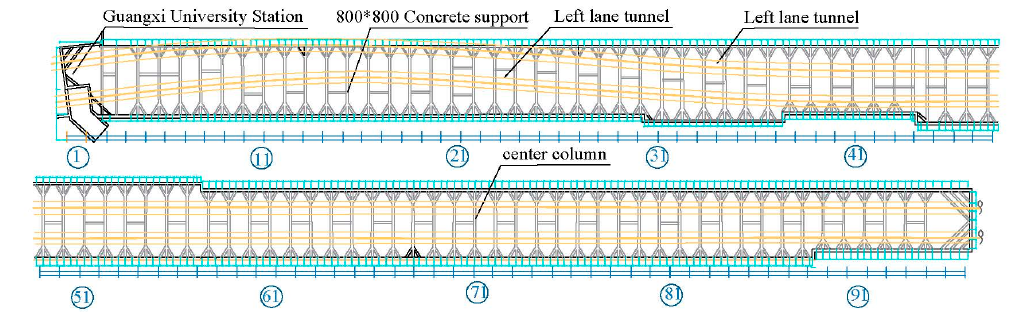
Figure 6. Supporting structure of DFP adjacent to the existing tunnel.